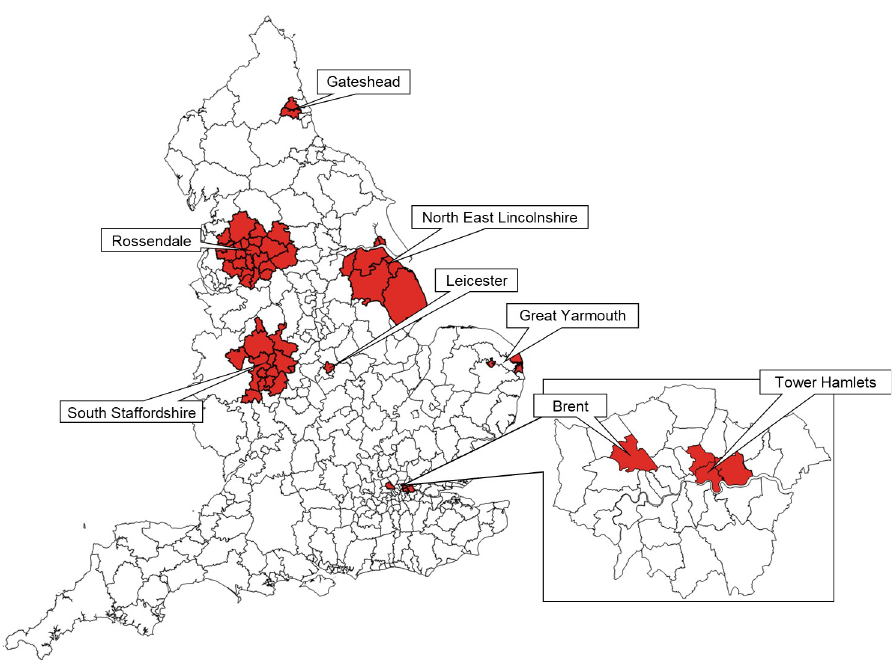
Fig 3. Short stature clusters in England (London inset) 2006–2019, adjusted for ethnicity ( n = 5,765,707). Short stature clusters are in red. Map base layer is shapefile Local Authority Districts (December 2017) Full Clipped Boundaries in Great Britain, published by the Office for National Statistics and available at https://geoportal.statistics. gov.uk/datasets/local-authority-districts-december-2017-full-clipped-boundaries-in-great-britain/explore?location= 55.450000%2C-2.950000%2C5.64&showTable=true.